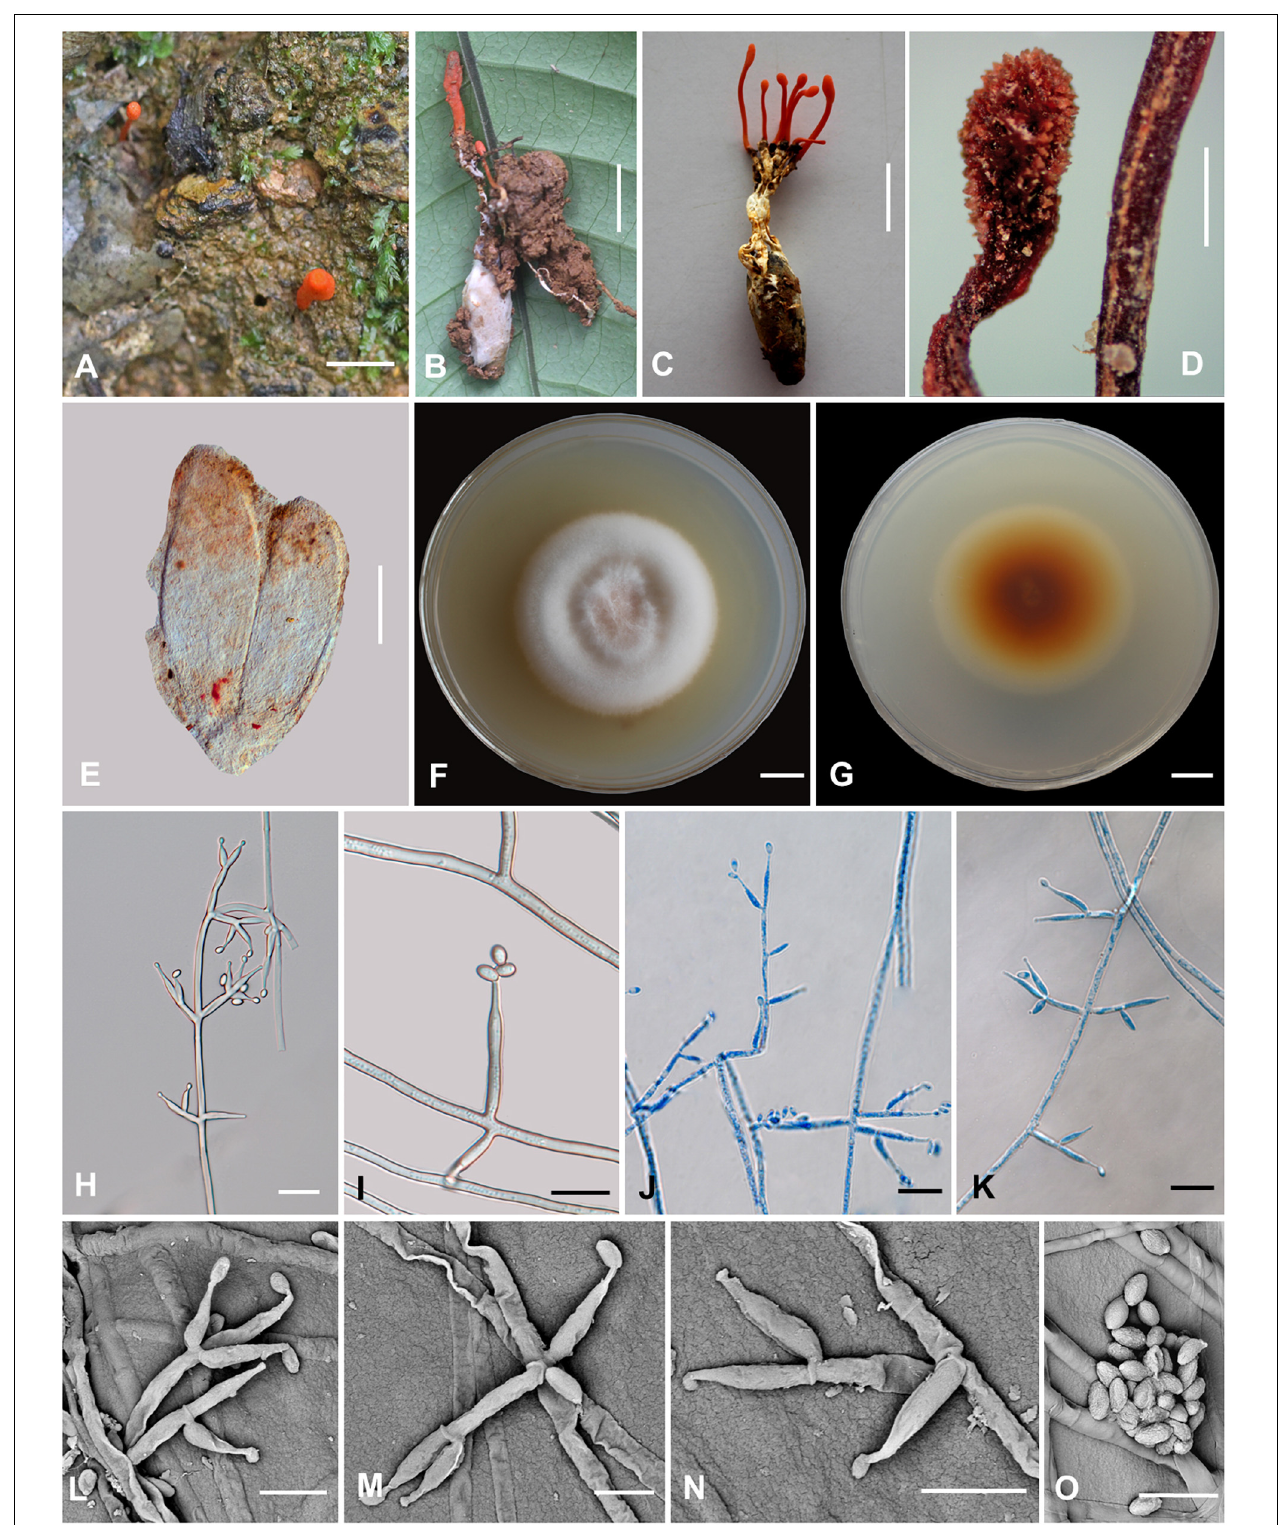
FIGURE 4 | Cordyceps nabanheensis. (A–C) Fungus on the pupa of Lepidoptera. (D) Fertile part. (E) Perithecia. (F,G) Colony obverse (F) and reverse (G) on PDA at 14 days. (I) Solitary phialide on hyphae. (H,J–N) Opposite conidiophore and verticillate phialides. (O) Conidia. Scale bars: (A–C) = 10 mm; (D) = 1 mm; (E) = 100 µ m; (F,G) = 10 mm; (H,J,K) = 20 µ m; (I) = 10 µ m; (L–O) = 5 µ